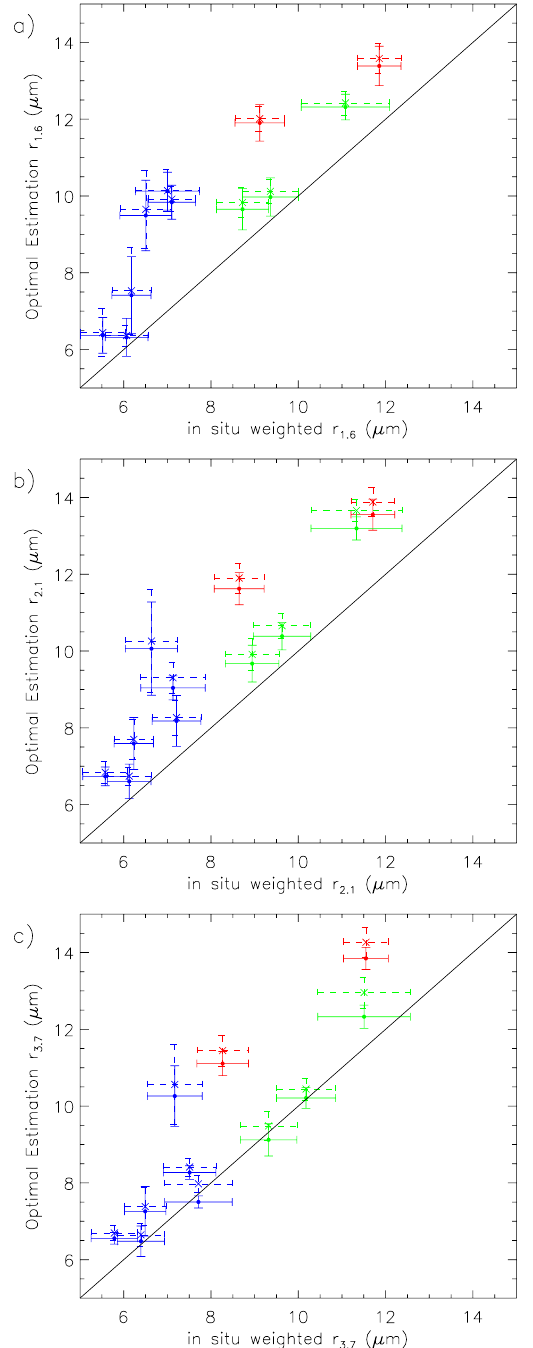
Fig. 11. Mean effective radii retrievals using an optimal estimation retrieval with in situ knowledge of water vapour and temperature profiles and against the equivalent MODIS retrievals.